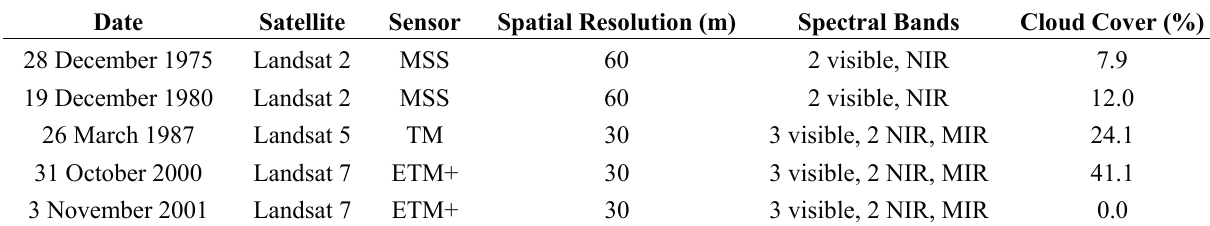
Table 1. Satellite data used.